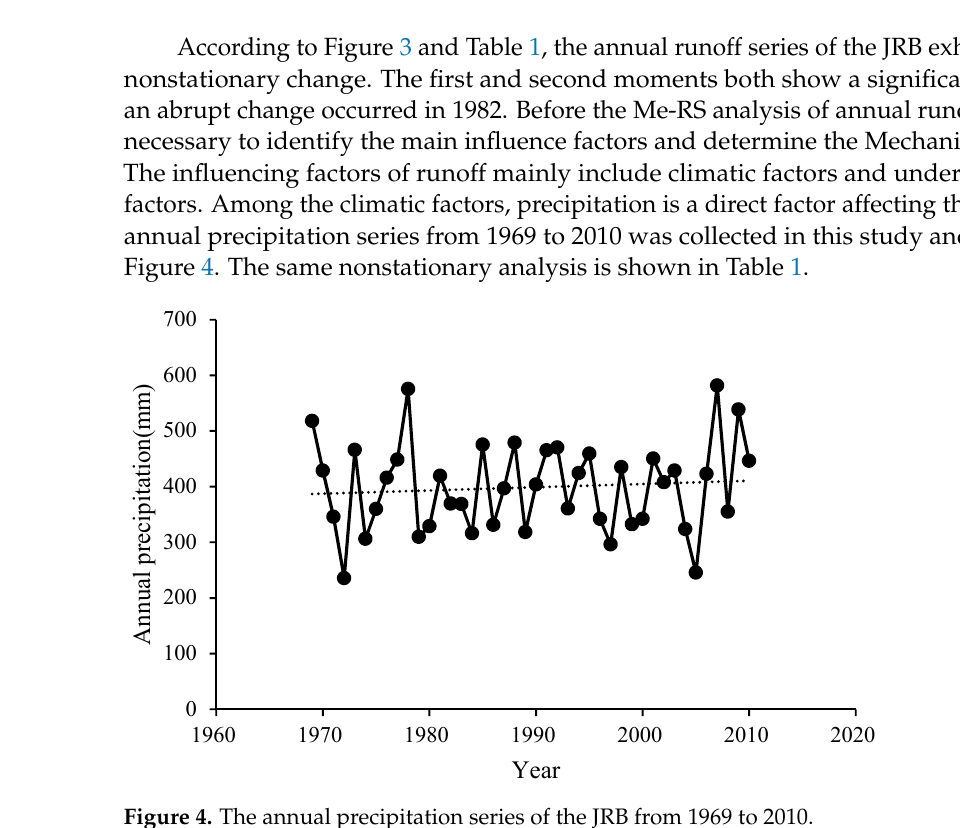
Figure 4. The annual precipitation series of the JRB from 1969 to 2010.